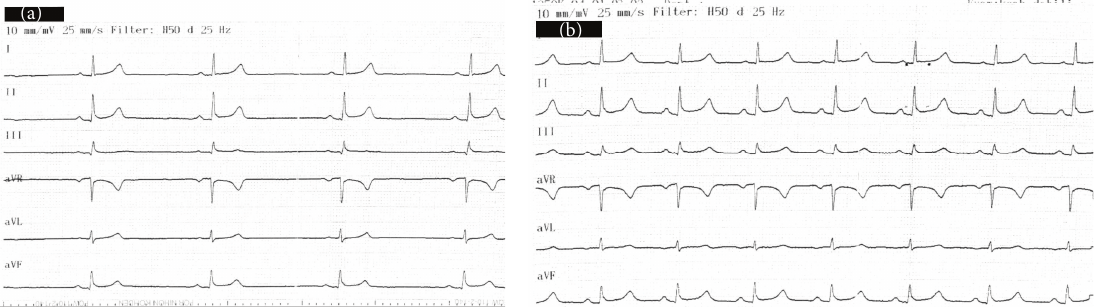
Figure 3: (a) Initial (before ILE treatment) electrocardiography of Case 3 with sinus bradycardia. (b) Electrocardiography of Case 3 after bolus infusion (5th minute of ILE) of intravenous lipid